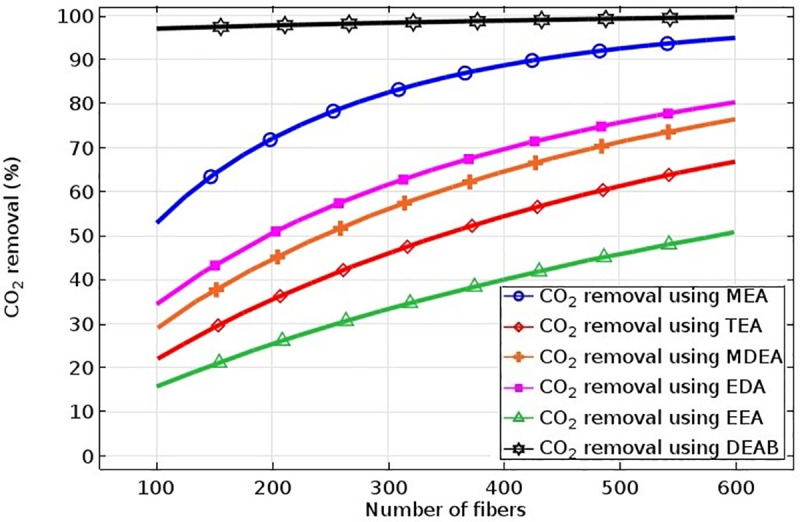
Impact of the number of fibers on the CO2 removal using MEA, TEA, EEA, EDA, MDEA and DEAB absorbents.